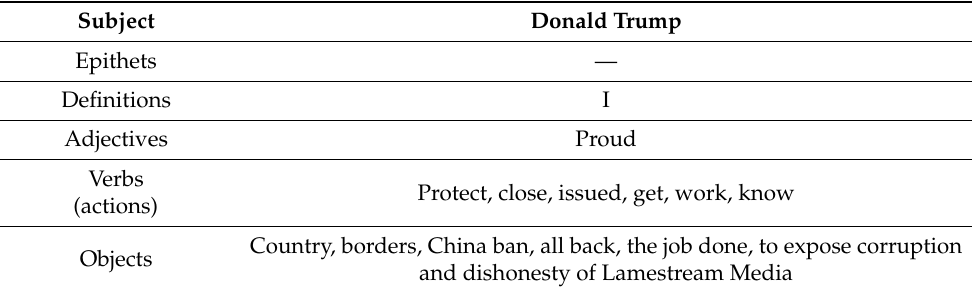
Table 11. Donald Trump.